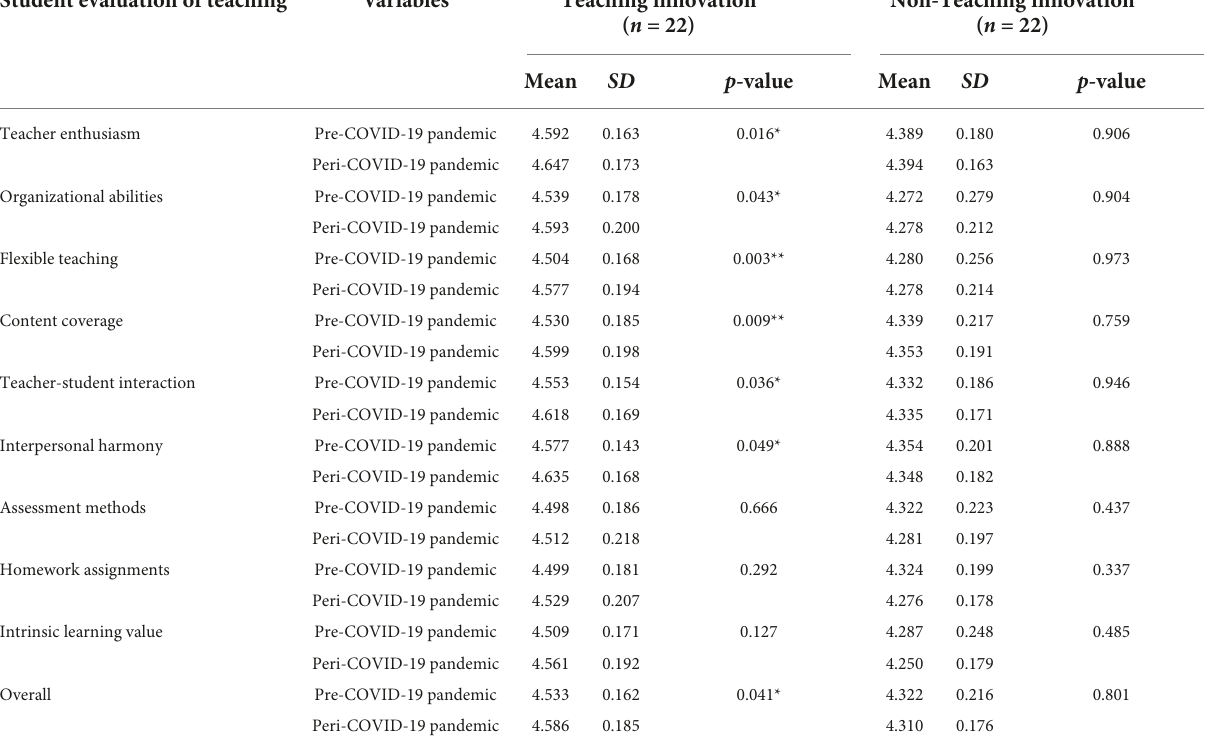
TABLE 2 Differences in SET in the pre- and peri-COVID-19 pandemic